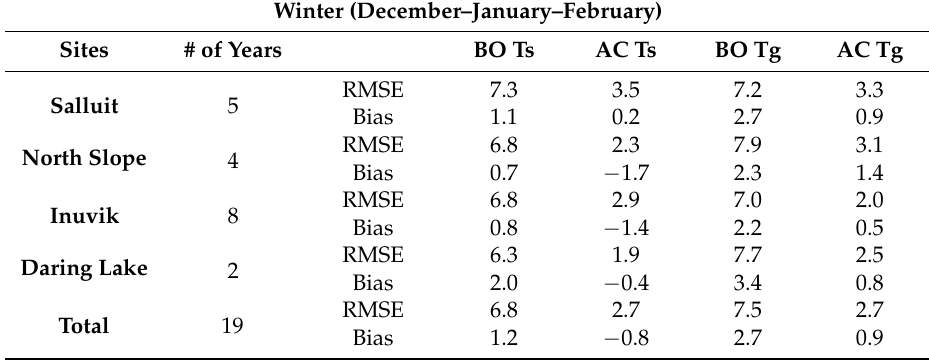
Figure 9. Results of the adjustment procedure using remote sensing (RS) data at Inuvik for winter 2008 (day/month) for soil temperature retrieval (Tg): ( a ) 19 GHz Tb comparison of measured (AMSR-E) and simulated (CLASS) at V polarization; ( b ) measured (MODIS) and simulated (CLASS) surface temperature; ( c ) measured (Station) soil temperature, simulated before optimization (BO) and after optimization (AO; meteorological adjustments), as well as simulated after snow density corrections (AC); ( d ) PR11 measured (AMSR-E) and simulated after optimization (AO) and after corrections (AC); and ( e ) snow thermal conductivity after optimization (AO) and after snow density correction (AC). Table 4. RMSE and bias (in K) at the four tundra sites for the studied winter time series, for the surface temperature (Ts) and soil temperature (Tg). BO refers to the values before the optimization procedure (meteorological adjustment) and AC to the values after correction of the snow density (see definitions in Table 2).